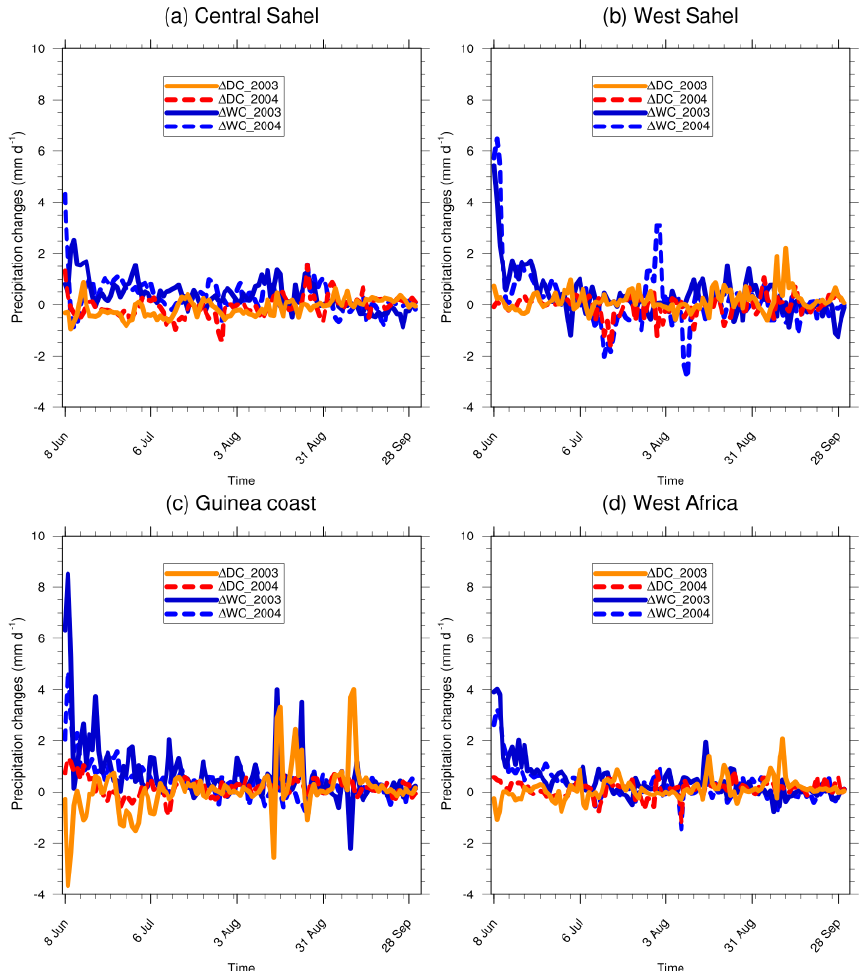
Figure 7. Daily domain-averaged precipitation changes for JJAS 2003 and JJAS 2004 from dry ( (cid:49) DC) and wet ( (cid:49) WC) experiments with respect to the control